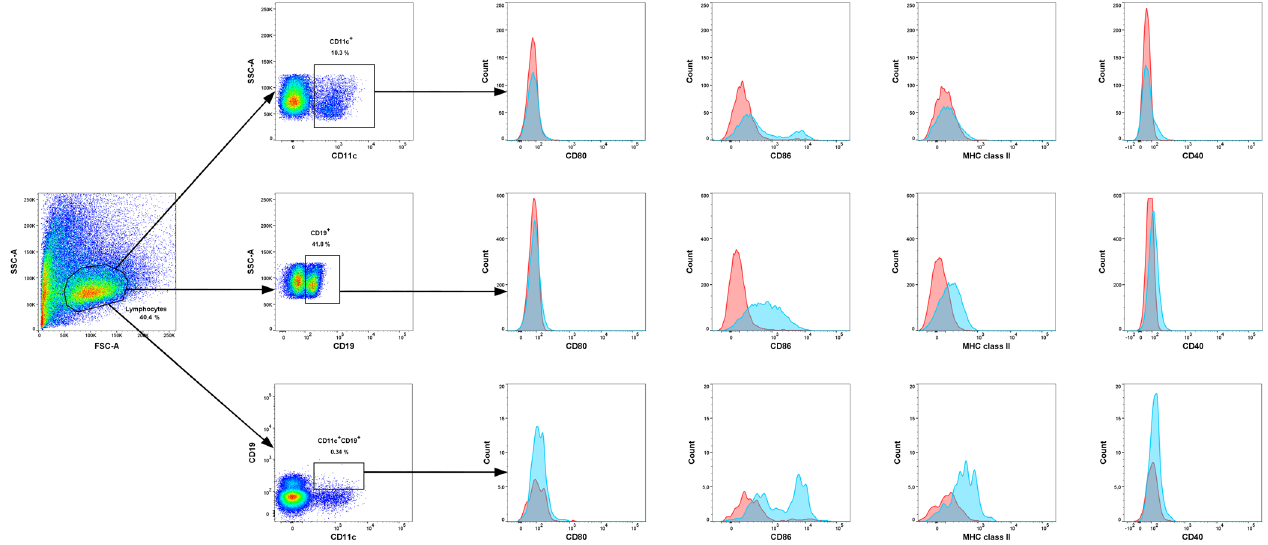
Figure 6. Representative overlay histograms comparing the expression of CD40, CD80, CD86 and MHC class II molecules (blue histograms) with that in the respective isotype-matched controls (red histograms) in CD11c + cells, CD19 + cells, and CD19 + CD11c + cells derived from spleen of abortion-prone